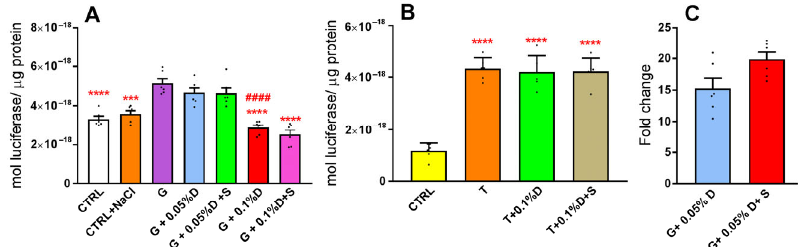
Figure 5. Effect of AKR1B1 inhibition on inflammatory response. ( A ) The expression of NF- κ B, reported as mol of luciferase/mg of protein, was measured through luminometric detection (see Section 2.4) after 24 h. CTRL and CTRL + NaCl refer to cells grown in MEM alone or supplemented with 14.4 mM NaCl, respectively. Different letters refer to the following addition to MEM: G, 75 mM D-glucose; D, DMSO; S, 50 µ M sorbinil. Values are reported as the mean ± SEM of six independent measurements. Statistical analysis was performed using one-way ANOVA with Tukey post hoc test. Significance was evaluated with respect to G (***: p < 0.001; ****: p < 0.0001) or with respect to G + 0.05%D ( #### : p < 0.0001). ( B ) The expression of NF- κ B, reported as mol of luciferase/mg of protein, was measured through luminometric detection (see Section 2.4) after 24 h. CTRL refers to